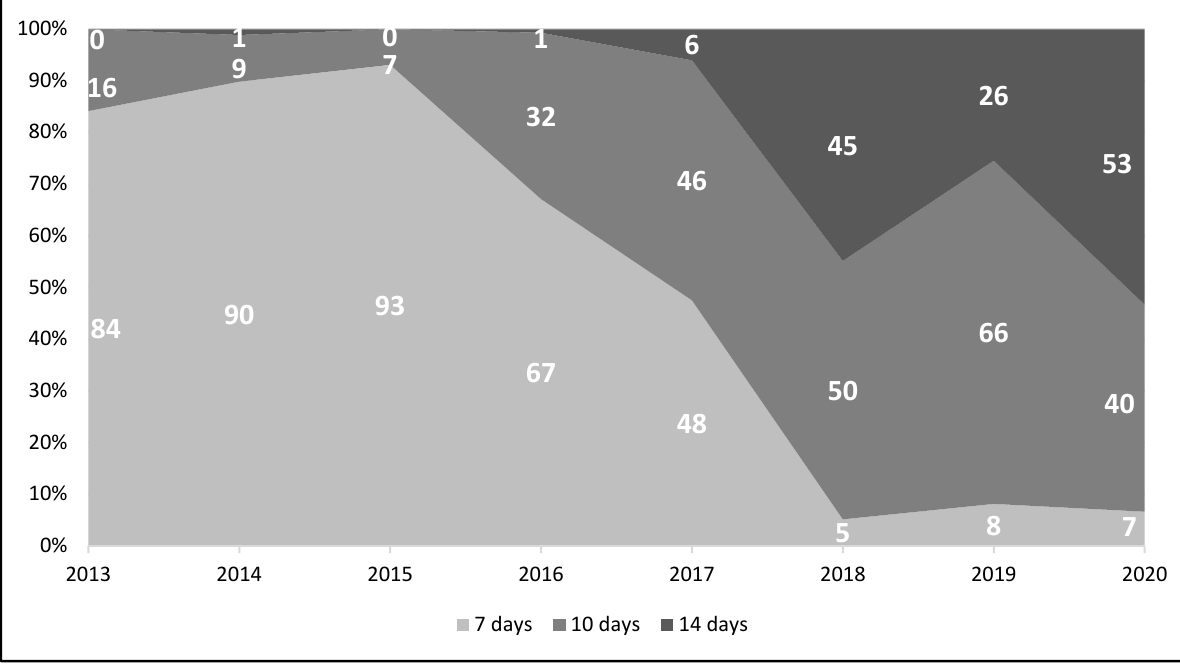
Figure 4. Trends of H. pylori eradication treatment duration during the years 2013–2020.